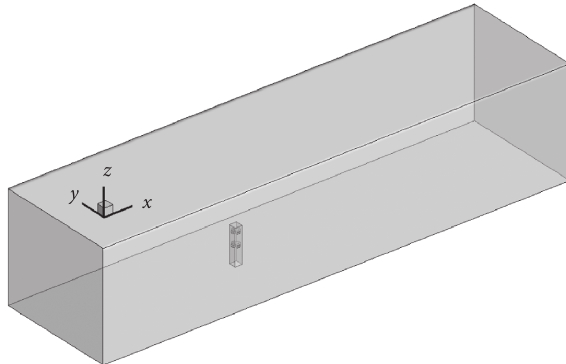
Figure 2: The computational domain in FLUENT.